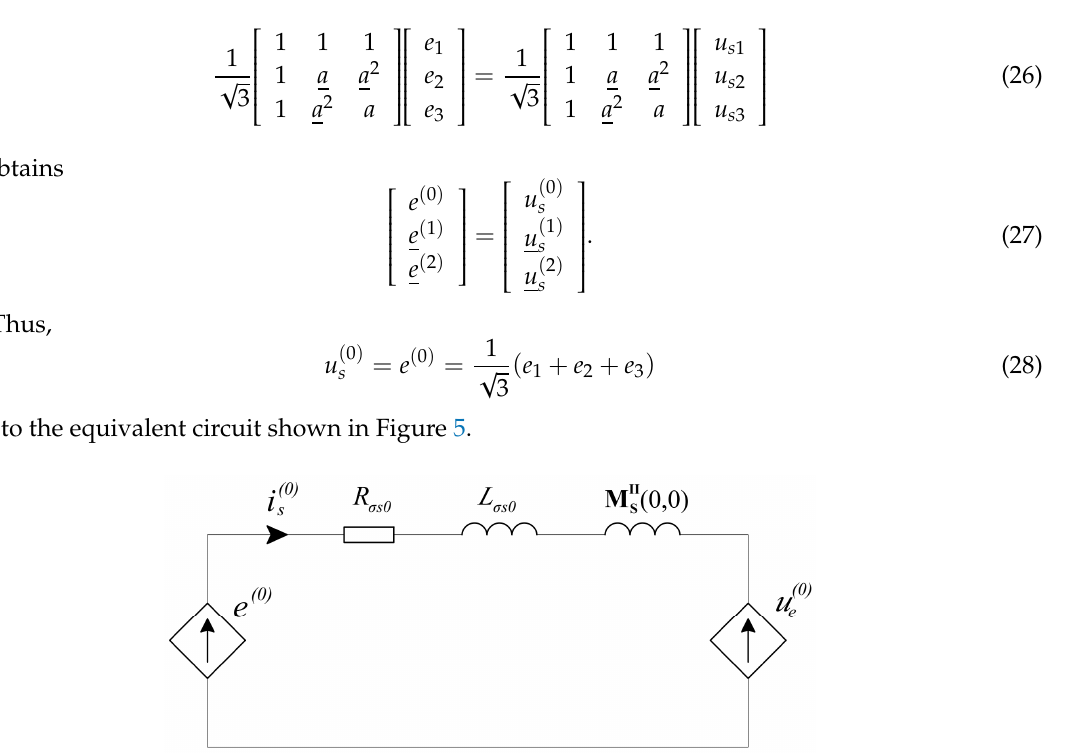
Figure 5. Equivalent circuit for the zero-sequence current component at the wye stator winding connection with the neutral wire.